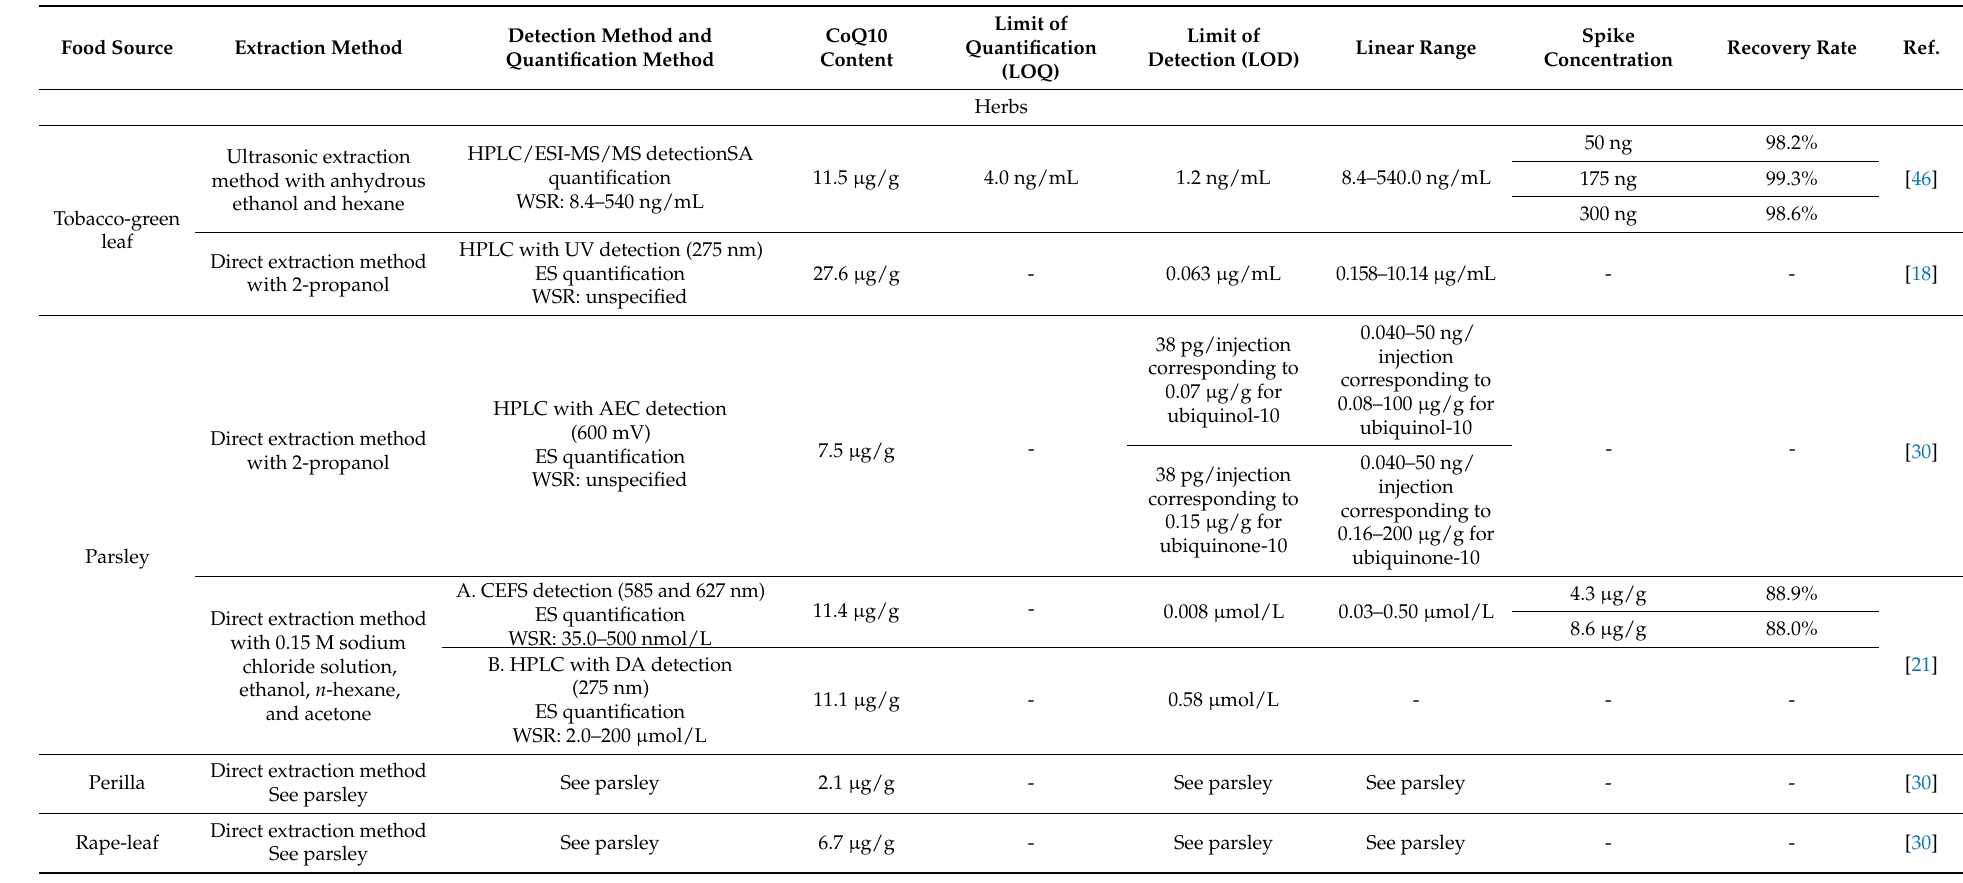
Table 1. Contents of CoQ10 in products of vegetable